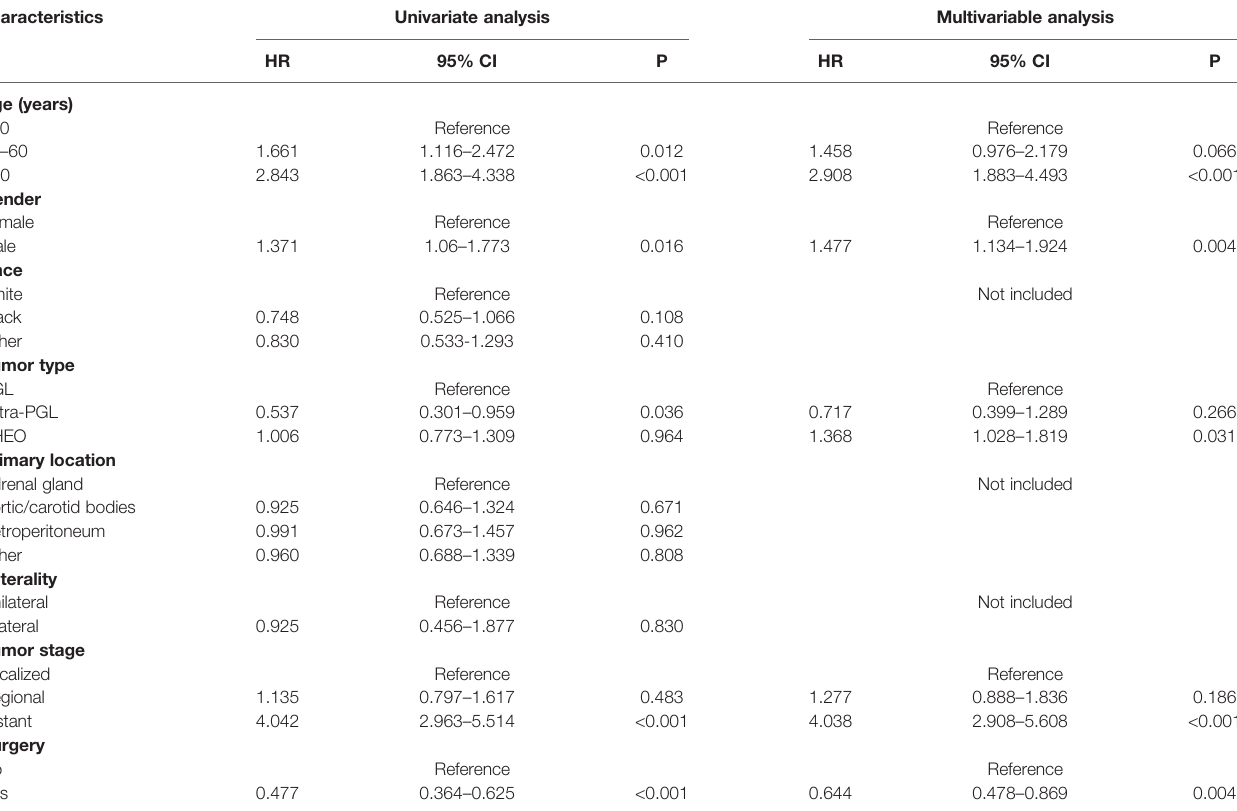
TABLE 2 | Univariate and multivariate Cox proportional hazards regression analyses of variables associated with overall survival.